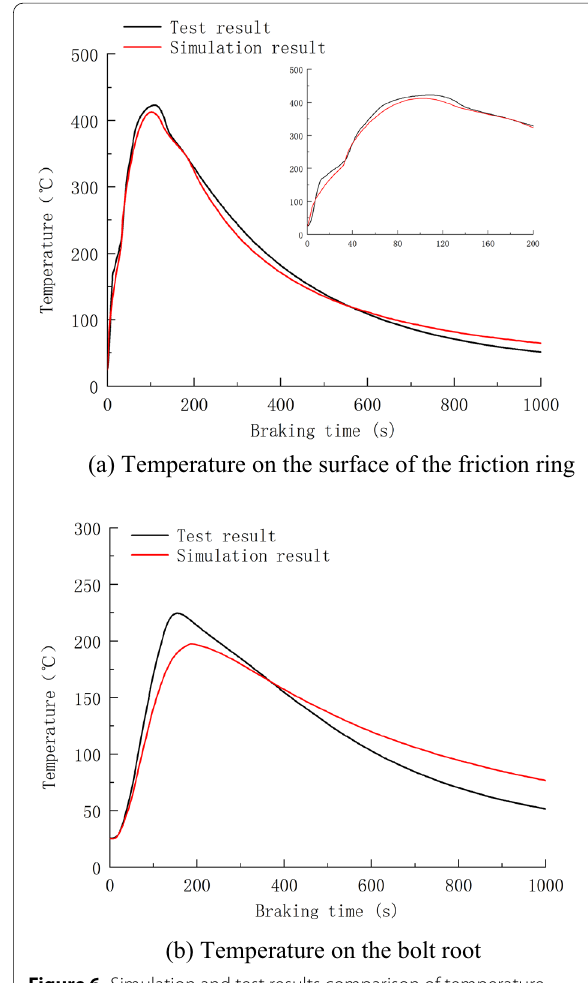
Figure 6 Simulation and test results comparison of temperature on the surface of the friction ring and bolt root under 300 km/h emergency braking condition Figure 7 Temperature changes with radius at different depths from